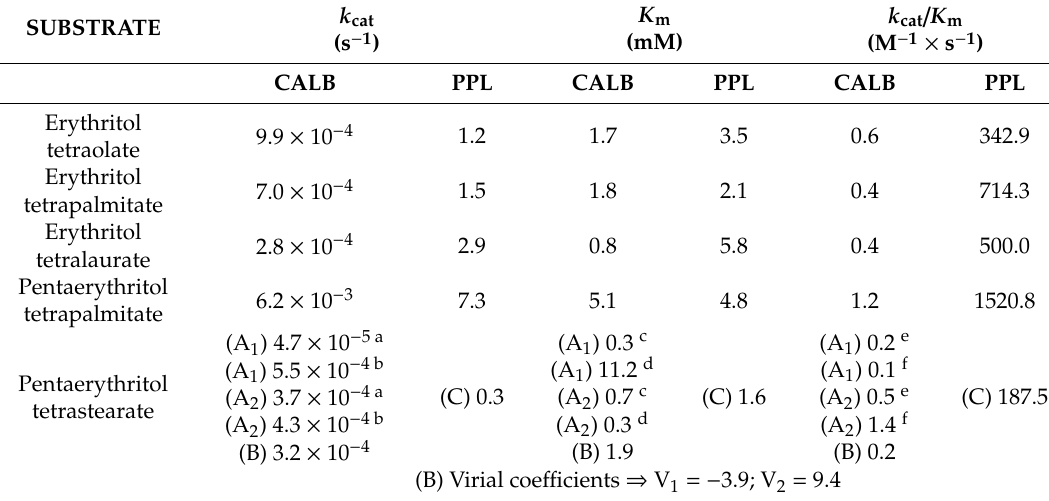
Table 1. The estimated parameters from the best fit of experimental data of the hydrolysis of the studied tetraesters by both Candida antarctica lipase-B (CALB) and porcine pancreas type VI-s lipase (PPL). The experimental data from the hydrolysis of pentaerythritol tetrastearate by CALB were best fitted by Equations (2) and